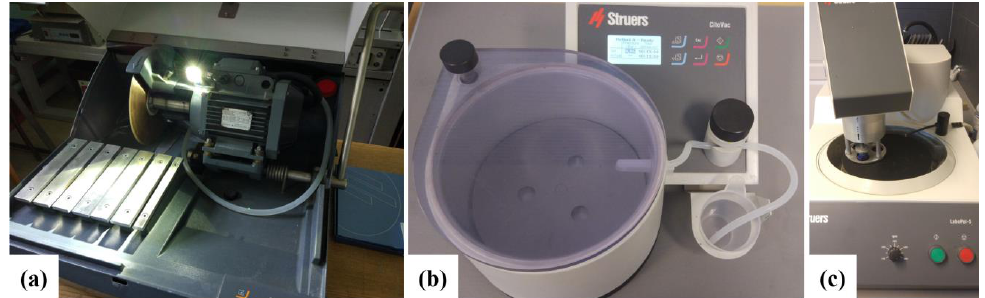
Figure 3. Equipment used for sample preparation: ( a ) Struers Labotom-5, ( b ) Struers CitoVac, ( c ) Struers LaboPol-5.